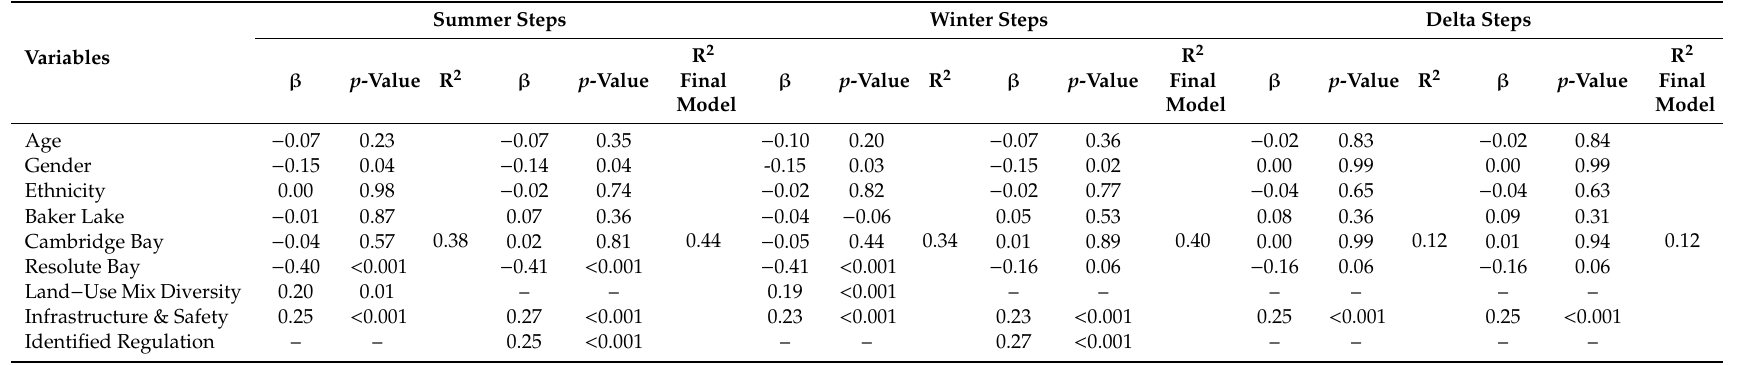
Table 4. Regression coe ffi cients, p -values and explained variance from regression analysis for the number of steps taken during the summer and winter seasons, and the change (delta) in the number of steps taken from summer to winter ( n =